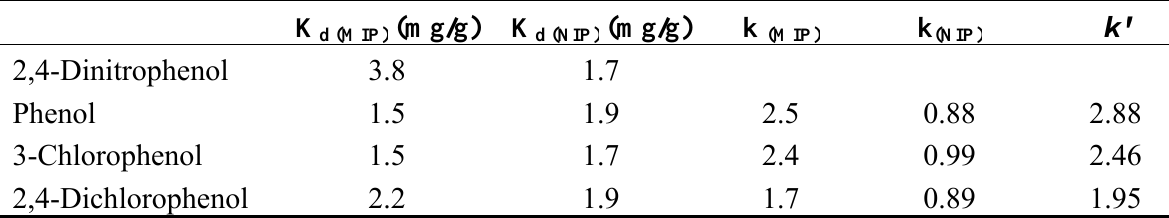
Table 1. Parameters involved in selectivity study of the MIP and NIP towards different kind of phenolic